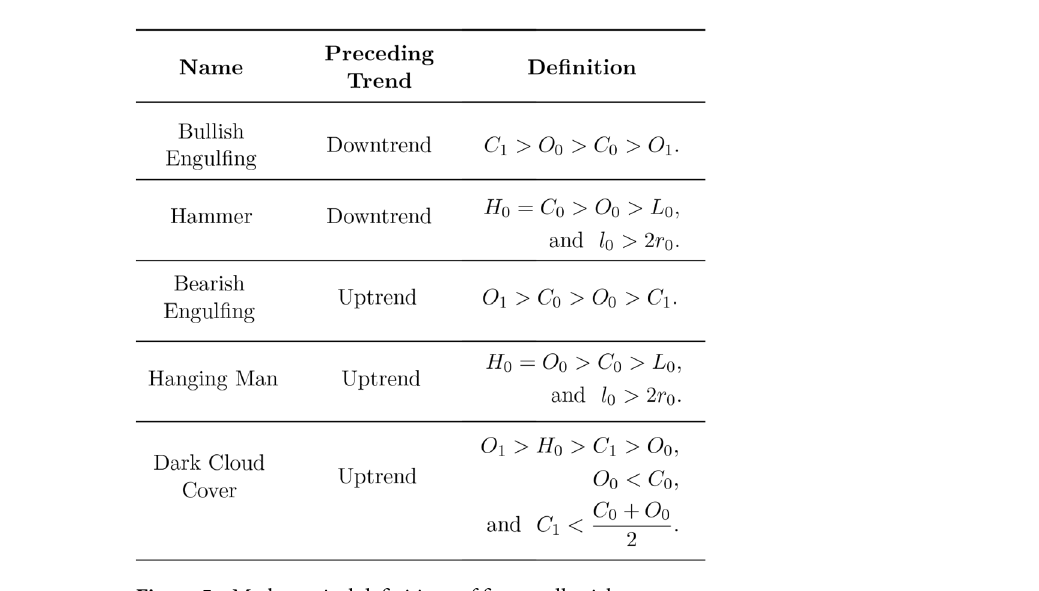
Figure 5. Mathematical definitions of five candlestick